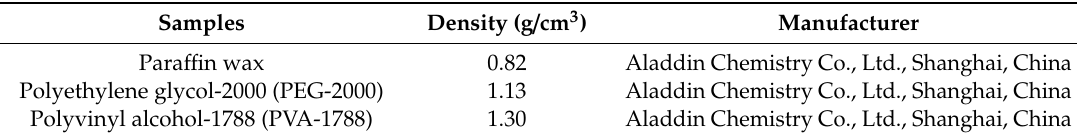
Table 2. Basic information about molding